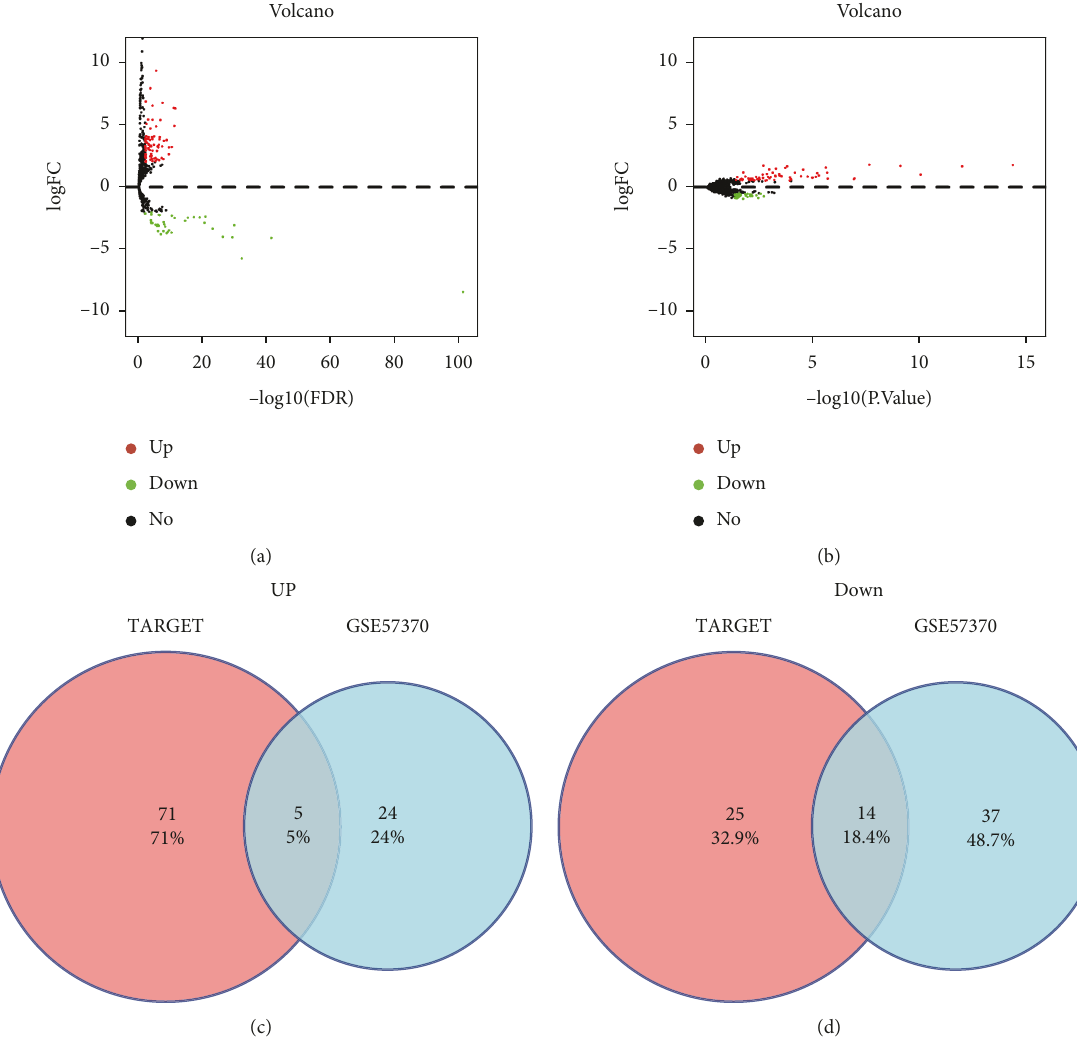
Figure 5: Identification of WT-specific miRNAs. Differentially expressed miRNA in TARGET (a) and GSE57370 (b) with the afore- mentioned cutoff thresholds was depicted in the volcano map. The red/green points represent the upregulation/downregulation of mRNAs, and the black points represent RNAs with no significant difference. the 5 upregulated (c) and 14 downregulated (d) WT-specific miRNAs convergence in both databases is presented in Venn